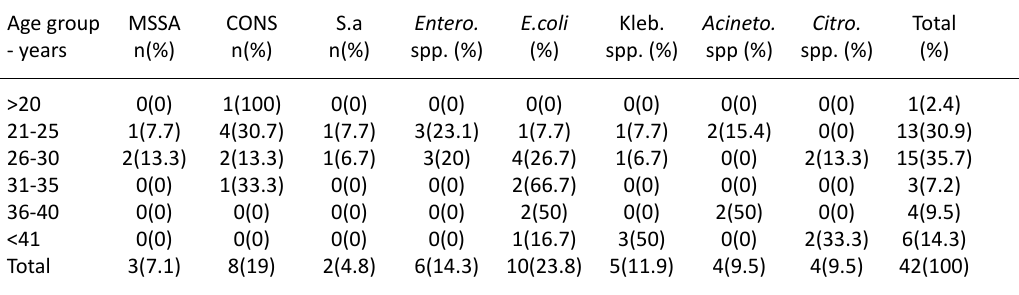
Table 2. Demography of aerobacterial isolates from causing vaginitis in infertility patients Age group MSSA CONS S.a